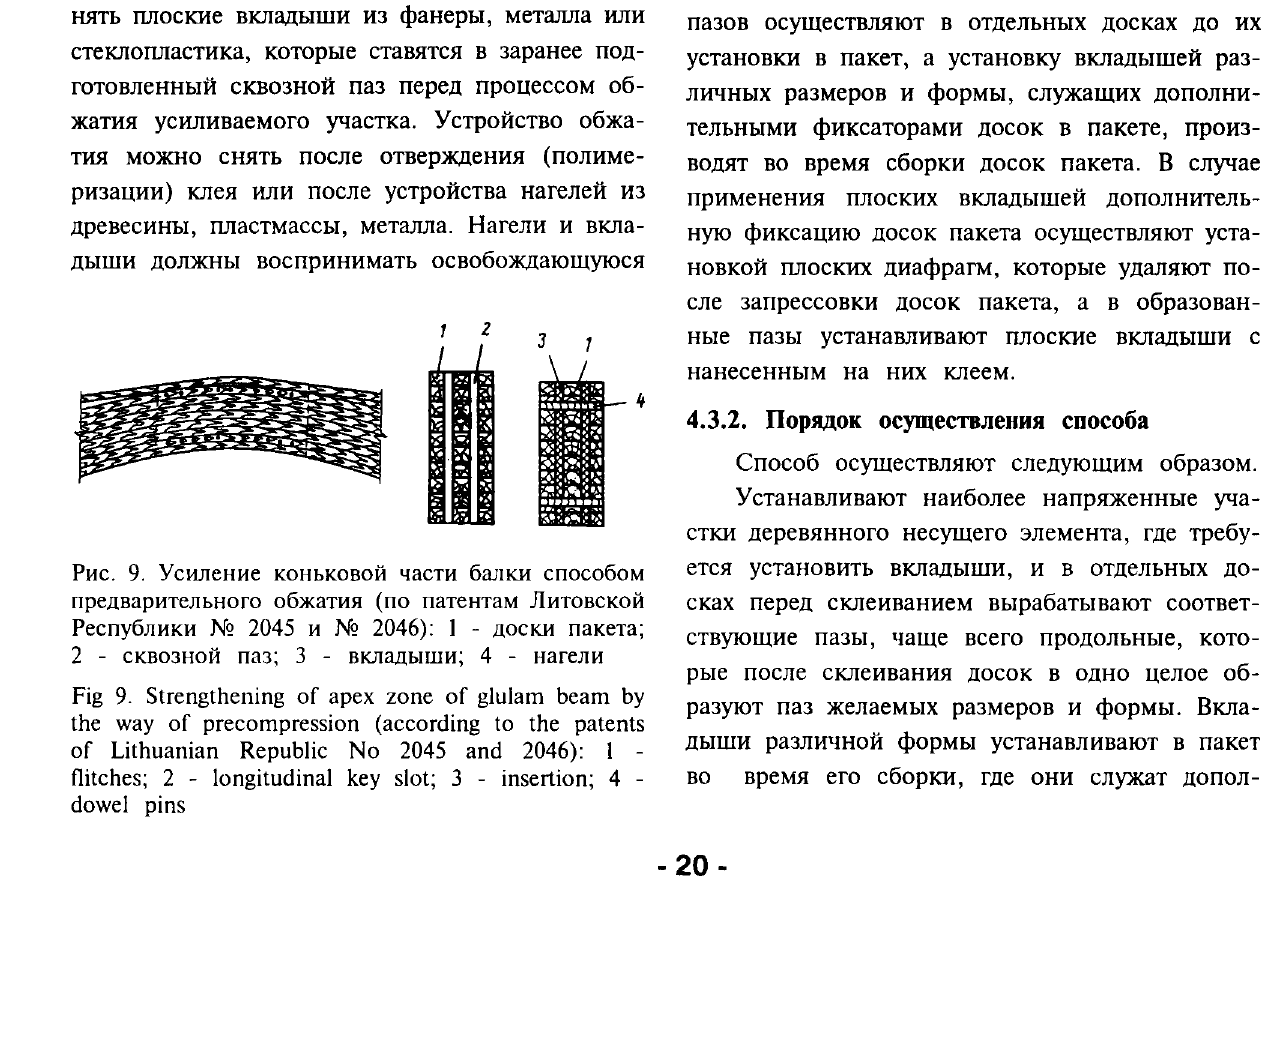
Fig 9. Strengthening of apex zone of glulam beam